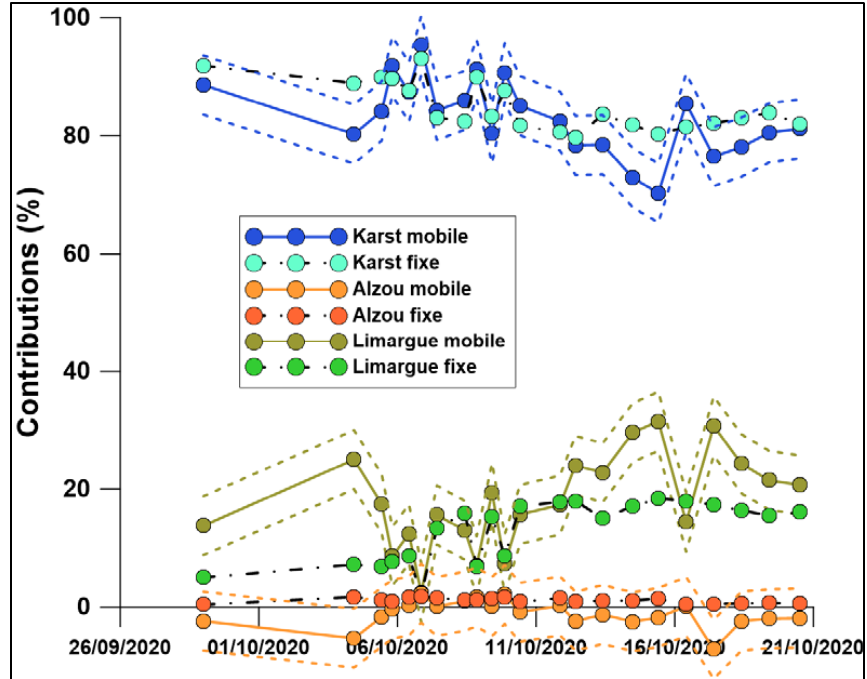
Figure 9. Contributions results of the mobile source mixing model for Fontbelle compared with fixed source model.